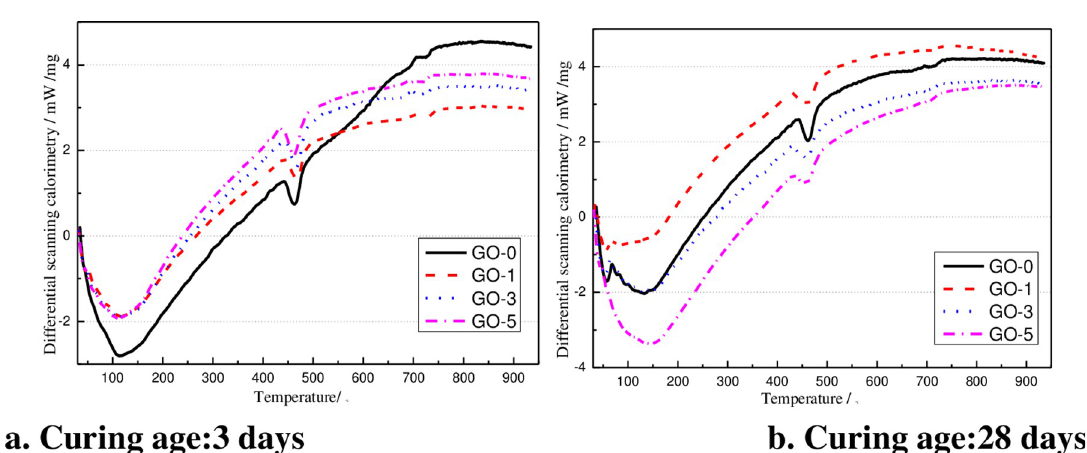
Fig 15. DSC thermograms of the cement pastes with the addition of GO at various curing ages.